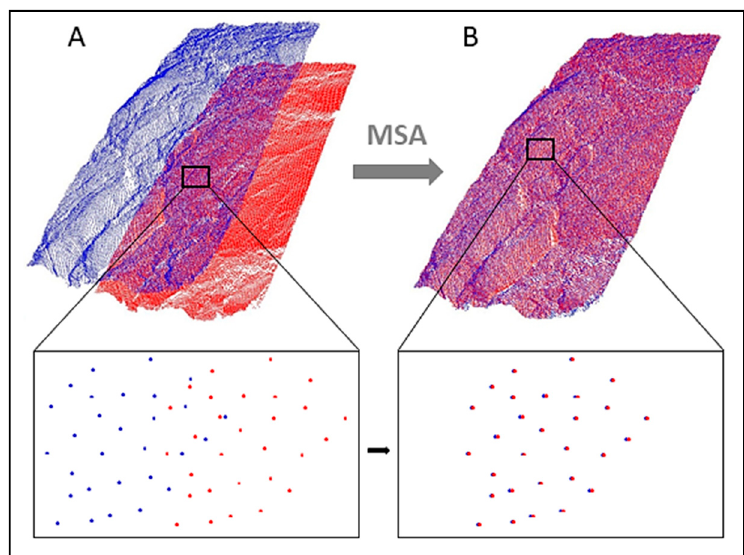
Figure 6. Demonstration of the Multi Station Adjustment method (MSA) implemented in the RiScanPro software by Riegl. First, the MSA requires two overlapping point clouds to be coarsely registered ( A ). Subsequently, the MSA results in a highly accurate spatial match of the two point clouds ( B ) in the order of millimeters achieved by the ICP.